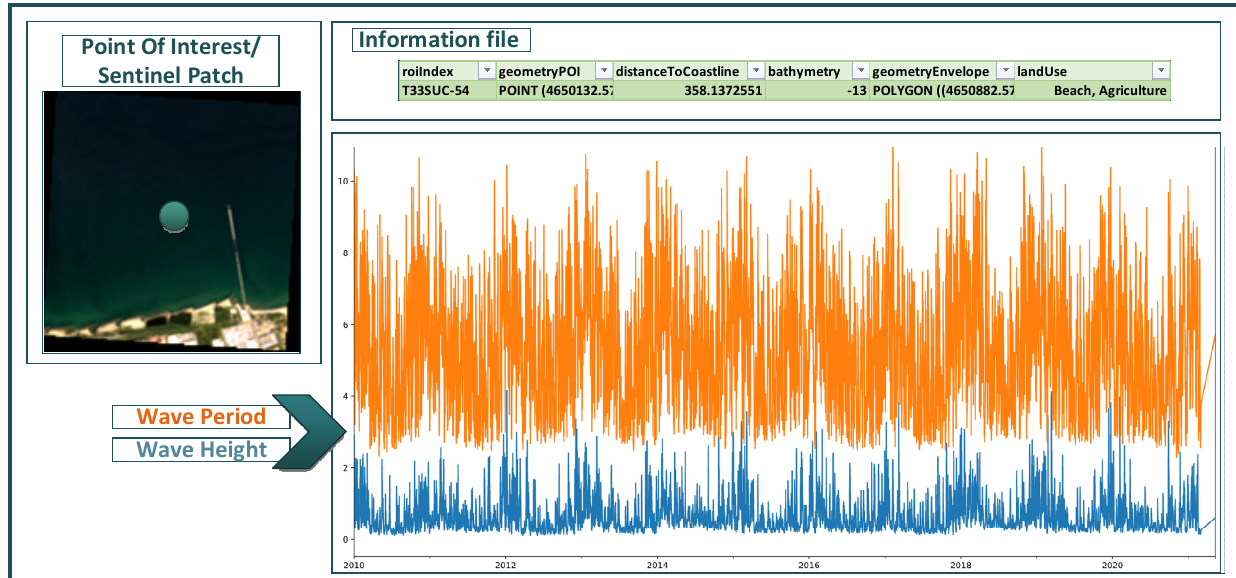
Figure 2. Example of a potential WEC installation point.